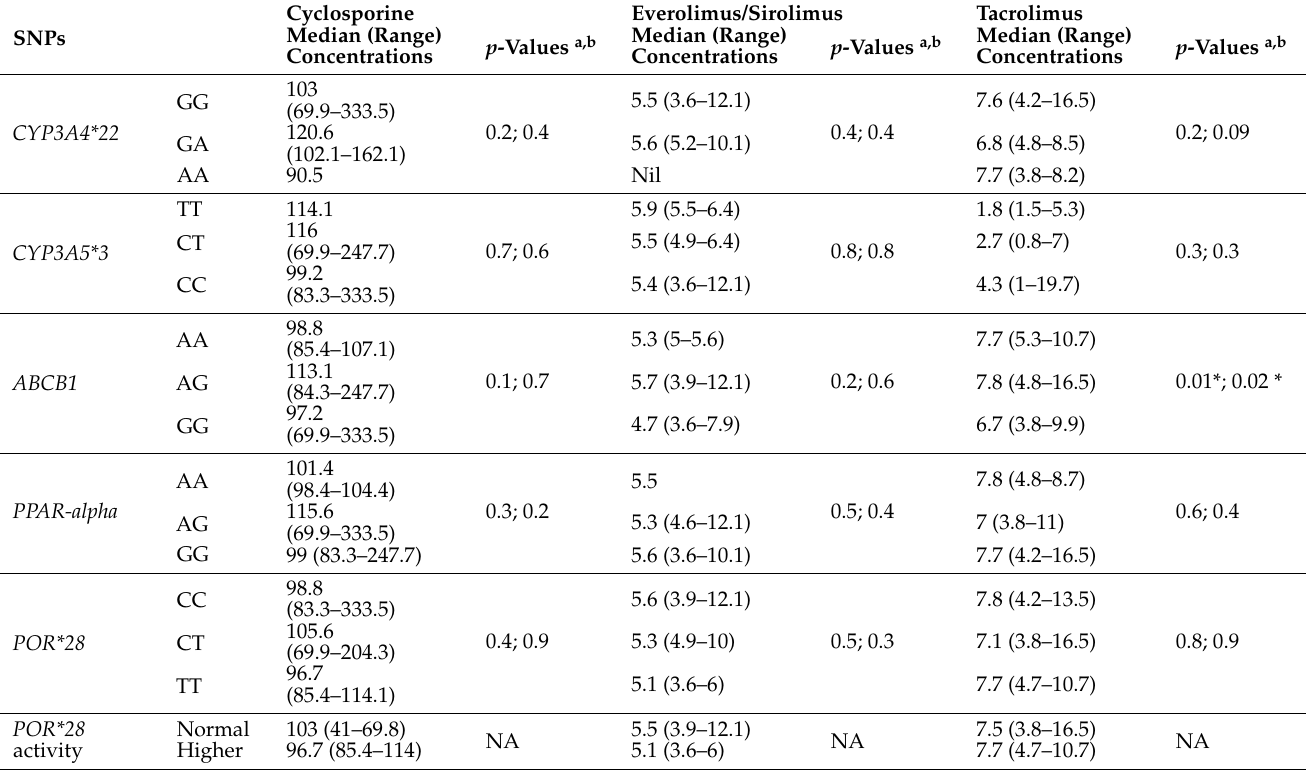
Table 5. Evaluation of mean drug concentrations with